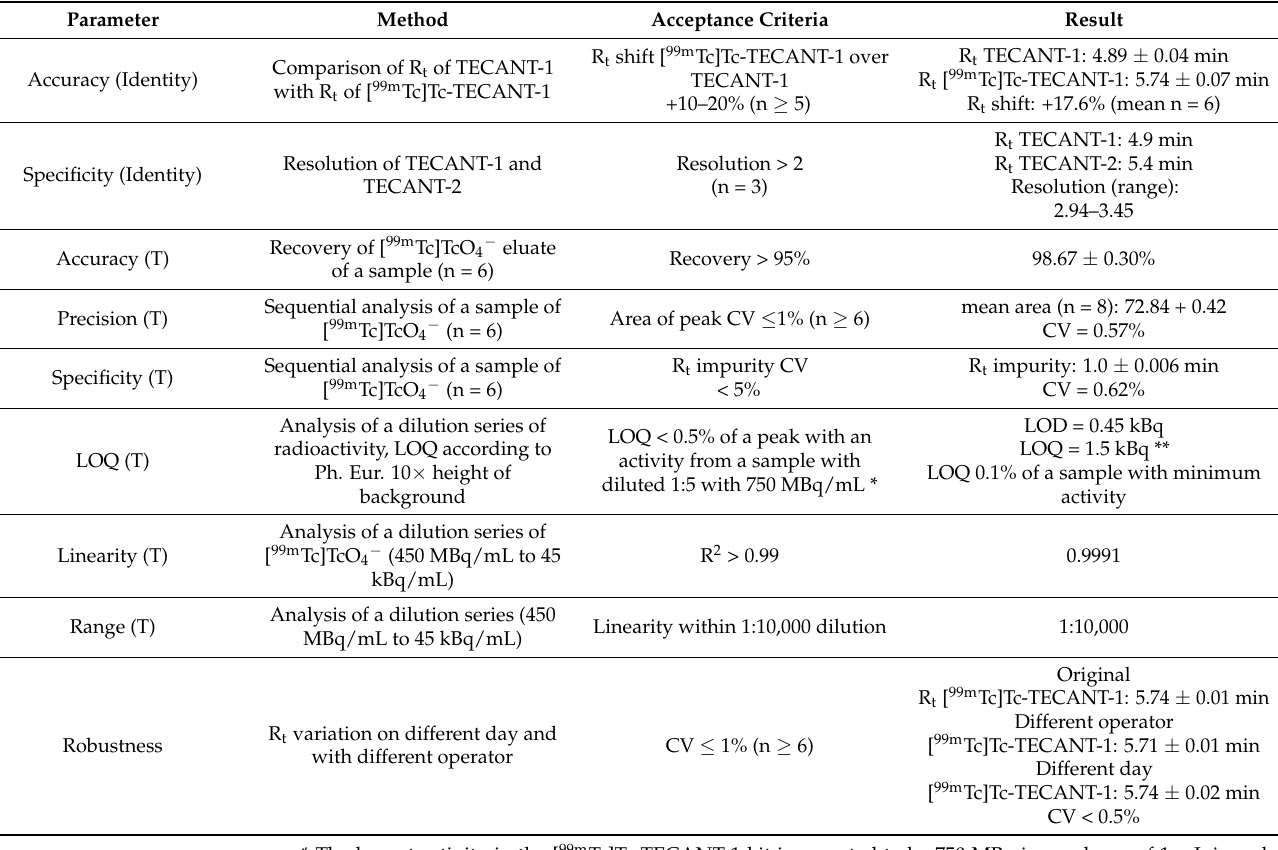
Table 1. Summary table of validation parameters, acceptance criteria and results for radio-(RP)HPLC method for determination of identity and percentage of 99m Tc-labelled TECANT-1 (% [ 99m Tc]Tc- TECANT-1 (HPLC)